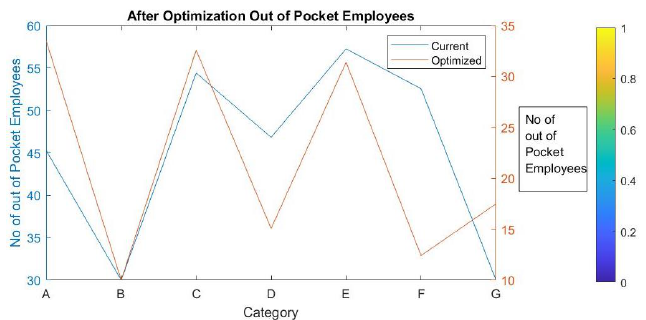
Figure 15. Number of Out of Pocket employees before and after